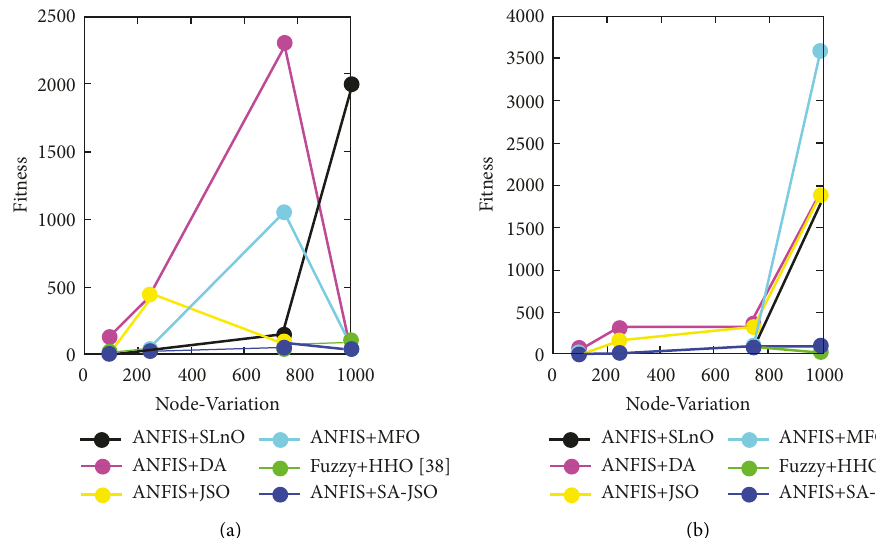
Figure 8: Analysis of PDR for developed approach over compared approaches regarding (a) group 1 and (b) group 2.